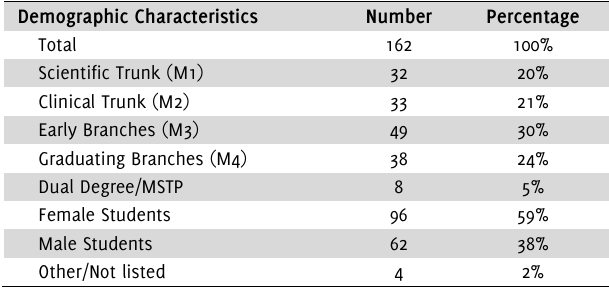
Table 2 . Sociodemographic information for survey